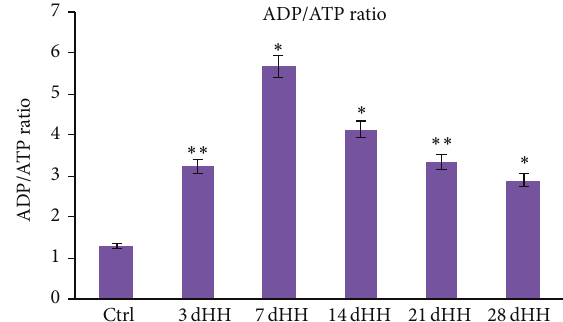
Figure2:GraphicalrepresentationdepictingADP:ATPchangeHH exposed whole hippocampal lysate compared to Cntrl. Result shows mean ± SEM for 𝑛 = 6 in each group. ∗ denotes 𝑝 < 0.05 compared to